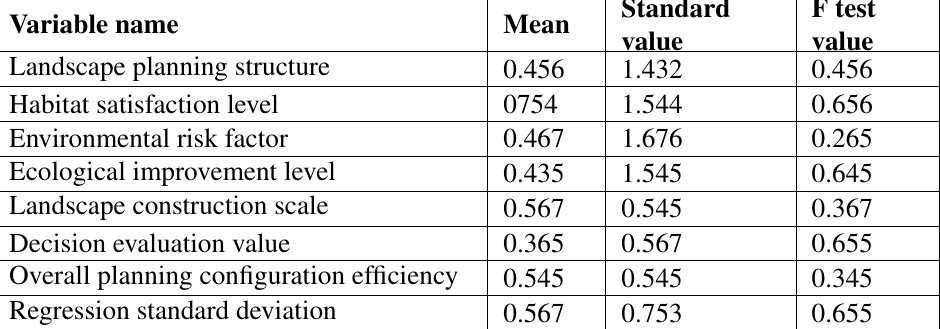
Fig. 4 Result of parameter design of a country house Table 2 Regression analysis value and test